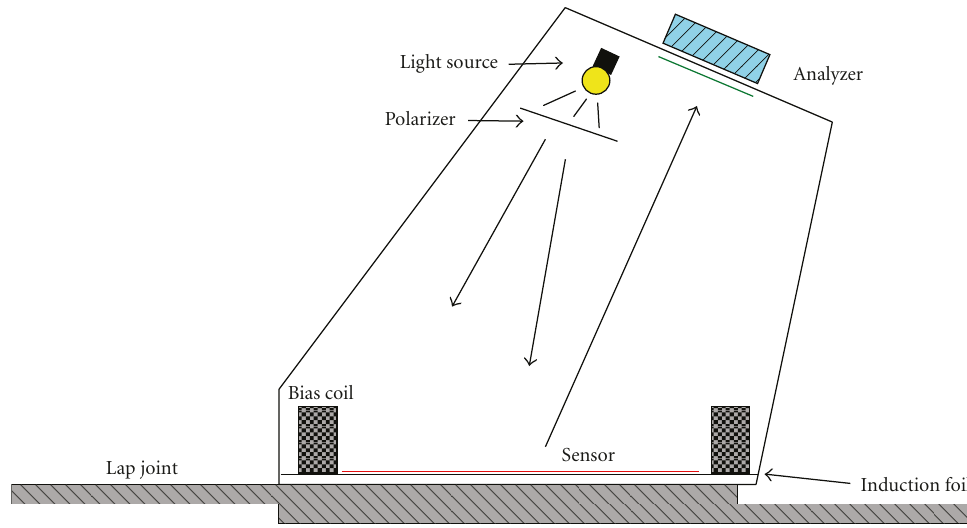
Figure 1: Schematic of the magneto optic imaging